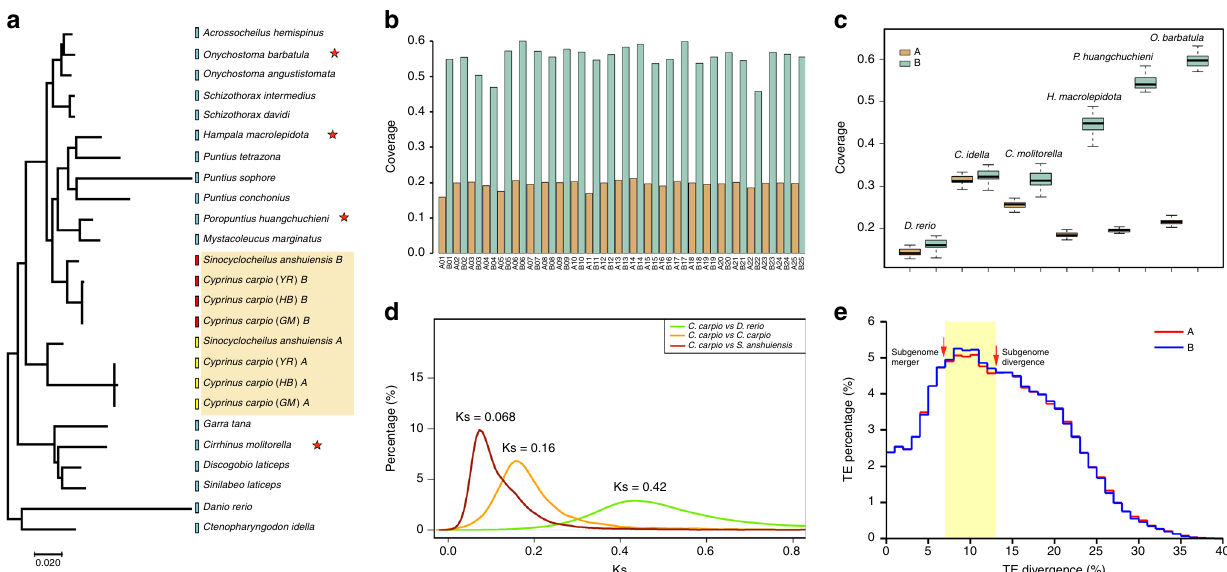
Fig. 2 Allotetraploid origin and evolution history of C. carpio . a Phylogenetic relationship of rag2 orthologues of C. carpio and its tetraploid and diploid close relatives in the subfamily Cyprininae. The pentagrams indicate three selected diploid species ( Poropuntius huangchuchieni , Hampala macrolepidota , and Onychostoma barbatulum ) as progenitor-like diploid candidates, and one species from a relatively distant lineage ( Cirrhinus molitorella ) for genome sequencing to represent the closely related diploid lineages from Cyprininae. b A histogram shows the coverage of P. huangchuchieni genome sequence mapping to 50 chromosomes of C. carpio . Chromosome IDs have been re-assigned to represent two sets of homoeologous chromosomes. c Boxplots show the genome coverage and similarity comparisons of diploid relatives to the tetraploid genome of C. carpio . d The distribution of the synonymous substitution rates (Ks) of homologous genes between D. rerio and C. carpio , C. carpi o and Sinocyclocheilus , and homoeologous genes between two subgenomes of C. carpio . Three peaks (Ks = 0.42, 0.16 and 0.068) of Ks distribution indicate the divergences of D. rerio and C. carpio , C. carpi o and Sinocyclocheilus , and two progenitors of C. carpio . e The distribution of sequence divergence rates of transposable elements (TEs) as percentages of subgenome sizes of C. carpio . The TE content segregation between subgenomes A and B indicates the events of diploid progenitor divergence and subgenome without exception, while no signi fi cant similarity or coverage differences were observed when the genome sequences of C.